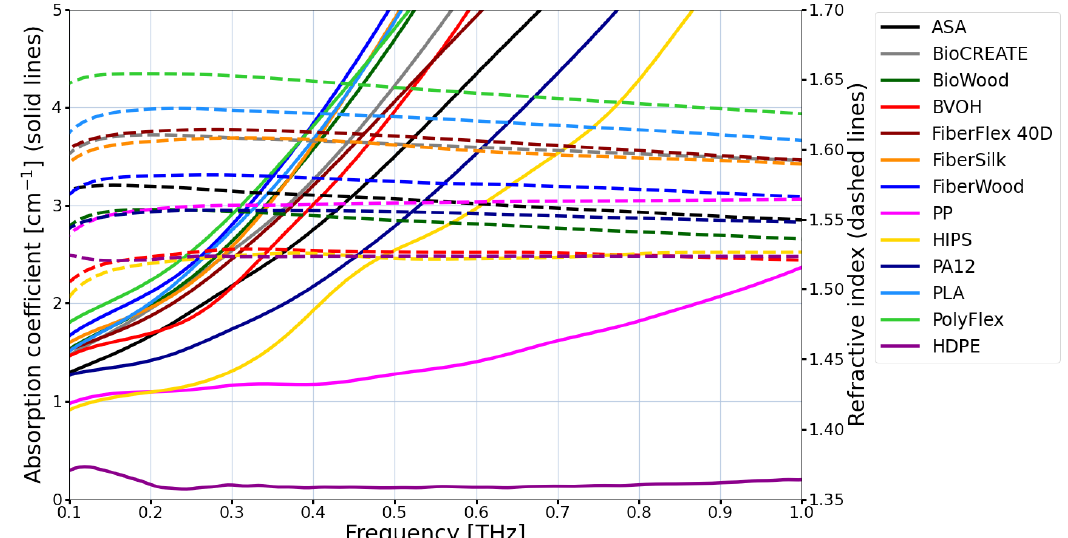
Figure 2. Refractive indices and absorption coefficients of exemplary materials available for extrusion-based 3D printing technique. High density polyethylene (HDPE) is illustrated as a reference material but it cannot be processed using this technique. The group of biopolymers—FiberWood, FiberSilk, BioCREATE and BioWOOD, thermoplastic polyurethane (PolyFlex) and thermoplastic polyester elastomer (FiberFlex 40D) are characterized with largest absorption coefficient values—similar to polylactide (PLA). The butenediol vinyl alcohol co-polymer (BVOH) together with acrylonitrile styrene acrylate (ASA) have slightly smaller absorption coefficient value. The most transparent (not taking into account reference HDPE) is polypropylene (PP), then high impact polystyrene (HIPS) and nylon–poliamid 12 (PA12). The refractive index values for all illustrated materials are in the range between 1.5 and 1.65, which is very similar to the values of refractive index for glass for visible